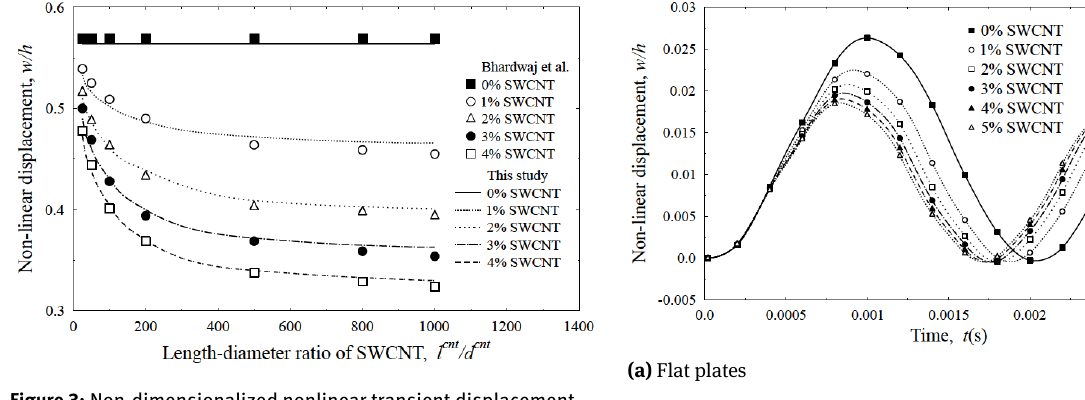
Figure 3: Non-dimensionalized nonlinear transient displacement ( w / h ) of SWCNT reinforced composite plates for different length- diameter ratios of SWCNT ([0/90/90/0])